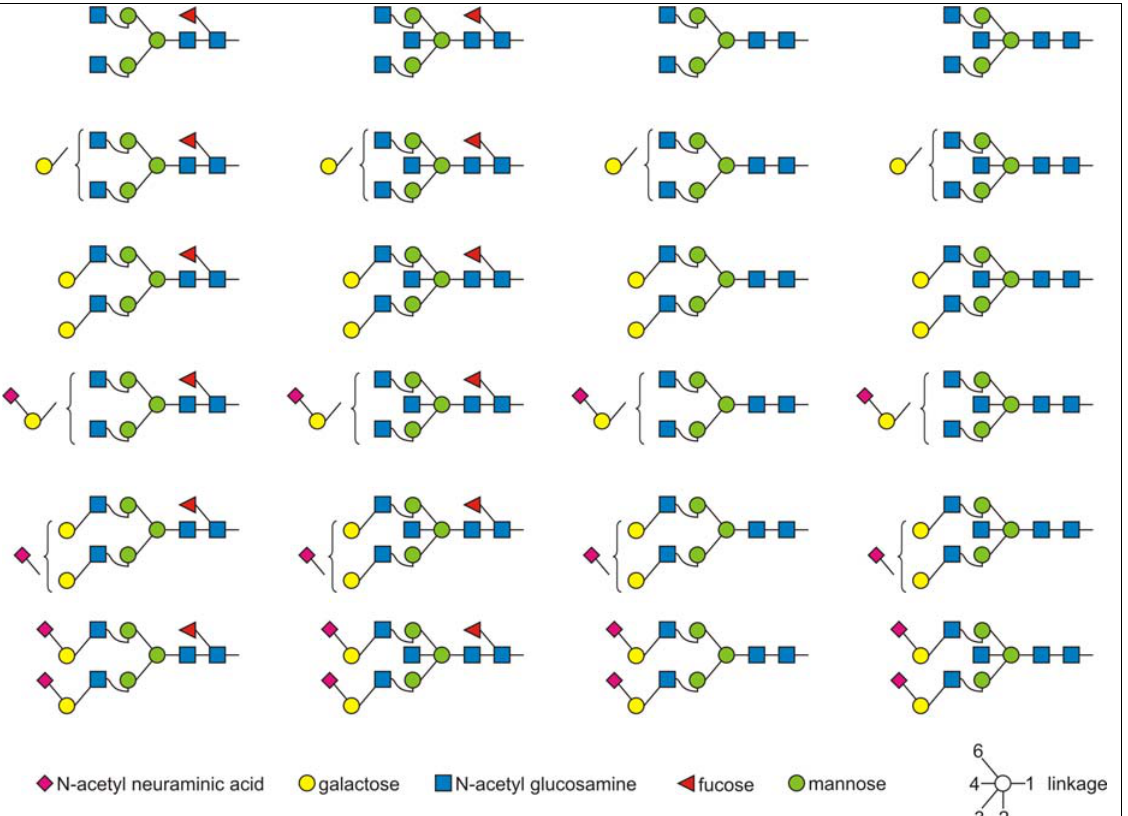
Figure 5. N-glycan structures of normal human polyclonal